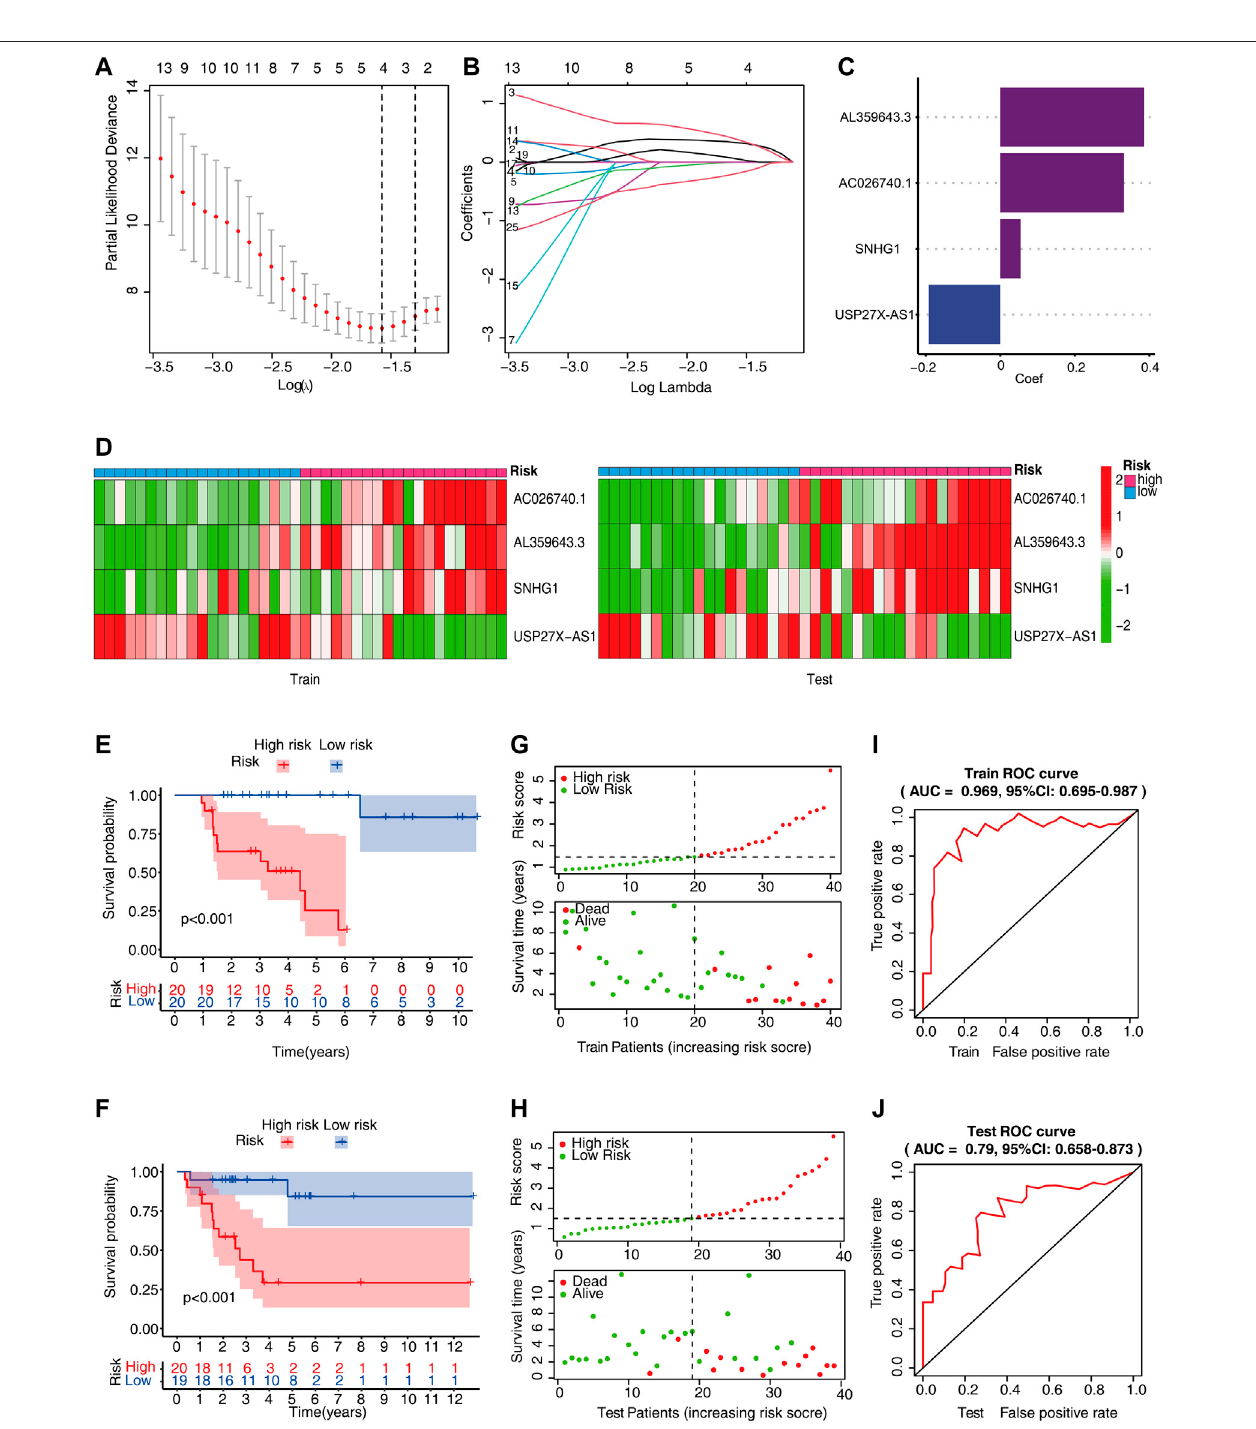
FIGURE4| Theriskscoreofm6A-related lncRNA. (A,B) Least absoluteshrinkageand selectionoperator (LASSO)regressionmodel. (C) With theminimallambda criteria, the coef fi cients of the LASSO-Cox model are listed. (D) Heatmap shows the expression levels of four lncRNAs in the training and test sets. (E,F) Kaplan – Meier curvesshow that the high-risk cohort has unfavorable OS compared tothe low-risk cohort inboth training and test sets. (G,H) Survivalstatus and riskscore distribution of ACC patients in TCGA dataset. (I,J) The m6A-LPS receiver operating characteristic (ROC) curves were used in the prediction of the patient ’ s OS.